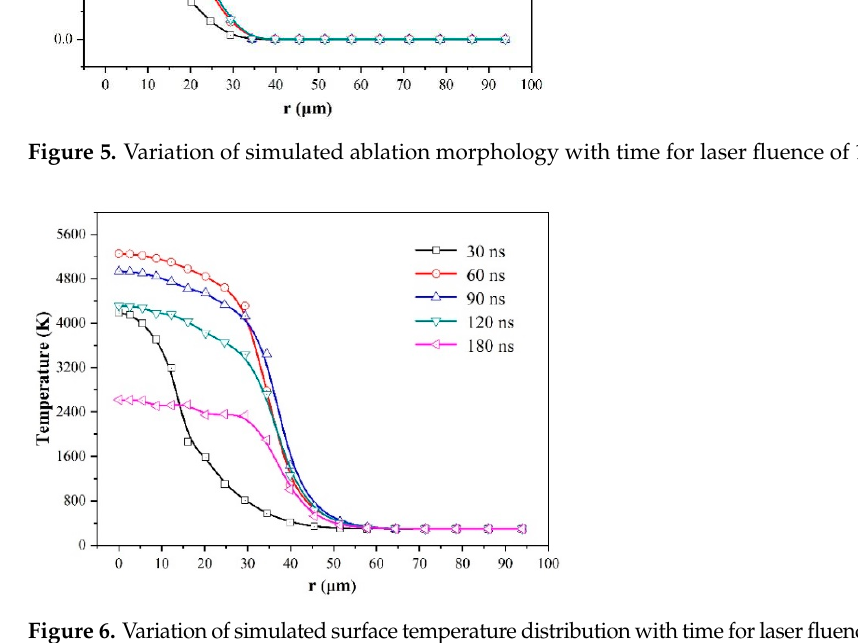
Figure 6. Variation of simulated surface temperature distribution with time for laser fluence of 19.3 J/cm 2.